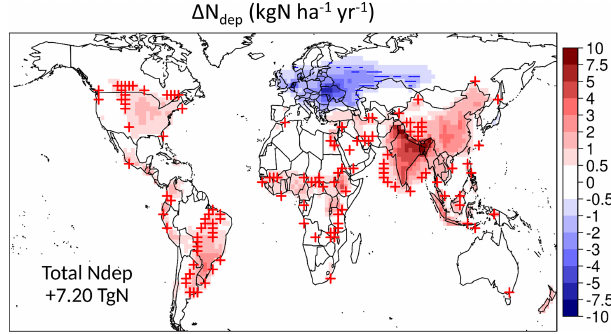
Figure 7. Changes in total nitrogen deposition ( (cid:49) N dep ) due to changes (1992–2014) in agricultural emissions and land cover. Red plus signs ( + ) mark new grid cells wherein total nitrogen deposi- tion exceeds 5kgNha − 1 yr − 1 , while blue minus signs ( − ) denote the grid cells wherein total nitrogen deposition decreases to below 5kgNha − 1 yr − 1